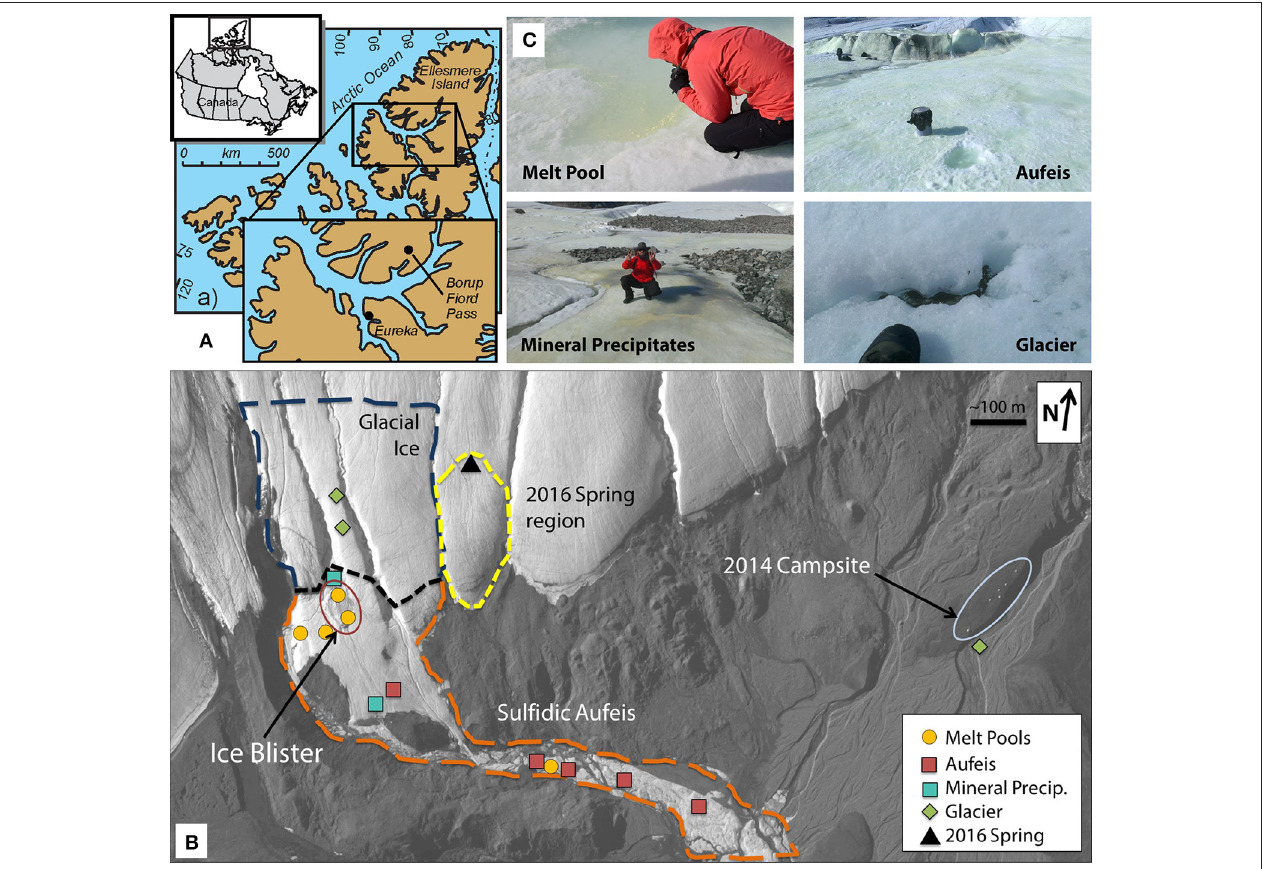
FIGURE 1 | Borup Fiord Pass: Sample locations and types. (A) Line drawing and map showing the location of Borup Fiord Pass in the Canadian High Arctic. The inset shows the location of Borup Fiord Pass on Ellesmere Island (from Grasby et al., 2012). (B) Satellite imagery of the toe of the coalescence glacier taken 2 July, 2014 during this sampling campaign. Highlighted sample sites are melt pool (gold circles), aufeis (red squares), mineral precipitates (teal square), and glacier samples (green diamonds). The location of the previous 2016 spring (black triangle) is also shown. Also highlighted are general regions: Glacial Ice (dark blue dashed line), Sulfidic Aufeis (orange dashed line), the area referred to as the Ice Blister (red oval), as well as the region of a newly emerged spring from 2016 (yellow dashed line). 2017 mineral precipitate samples are not shown, however, samples were collected within the Sulfidic Aufeis zone near the Ice Blister from 2014 (this can be seen in Figure S3a). Also note the location of the 2014 campsite on the far east side of the figure for added scale. (C) Examples of melt pool (top left), aufeis (top right), mineral precipitate (bottom left), and glacier (bottom right) sample types. Professor Alexis Templeton (top left), a five gallon rock pail (top right), Dr. Graham Lau (bottom left), and a hiking boot (bottom right) for relative scale. Satellite image courtesy of the DigitalGlobe Foundation